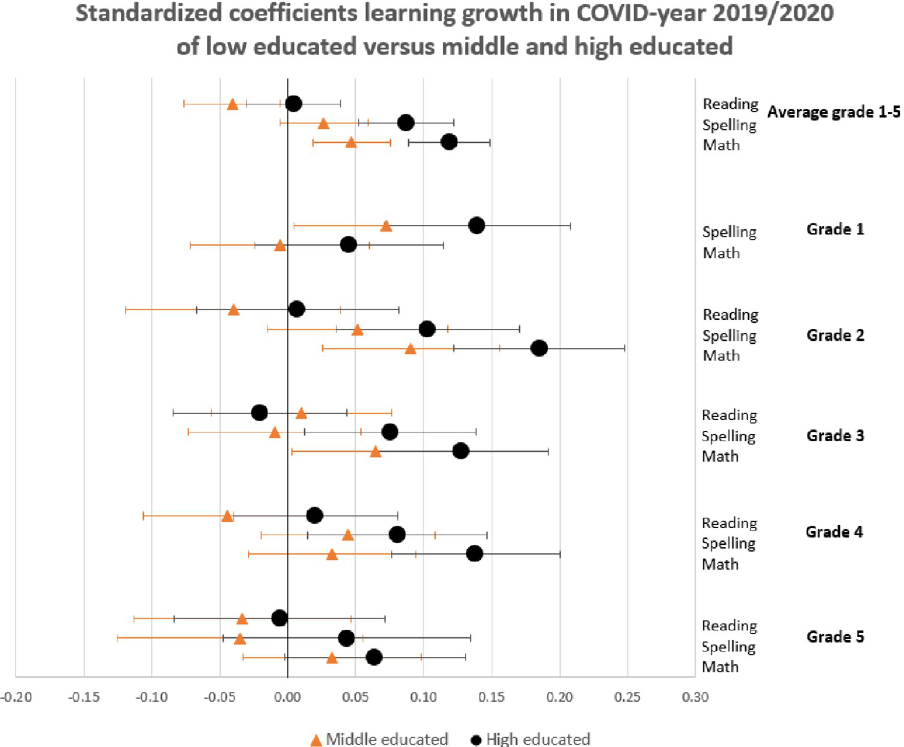
Fig 2. Standardized coefficients of learning gains in COVID-19-year 2019/2020 of low-educated (zero line) versus middle- and high-educated.